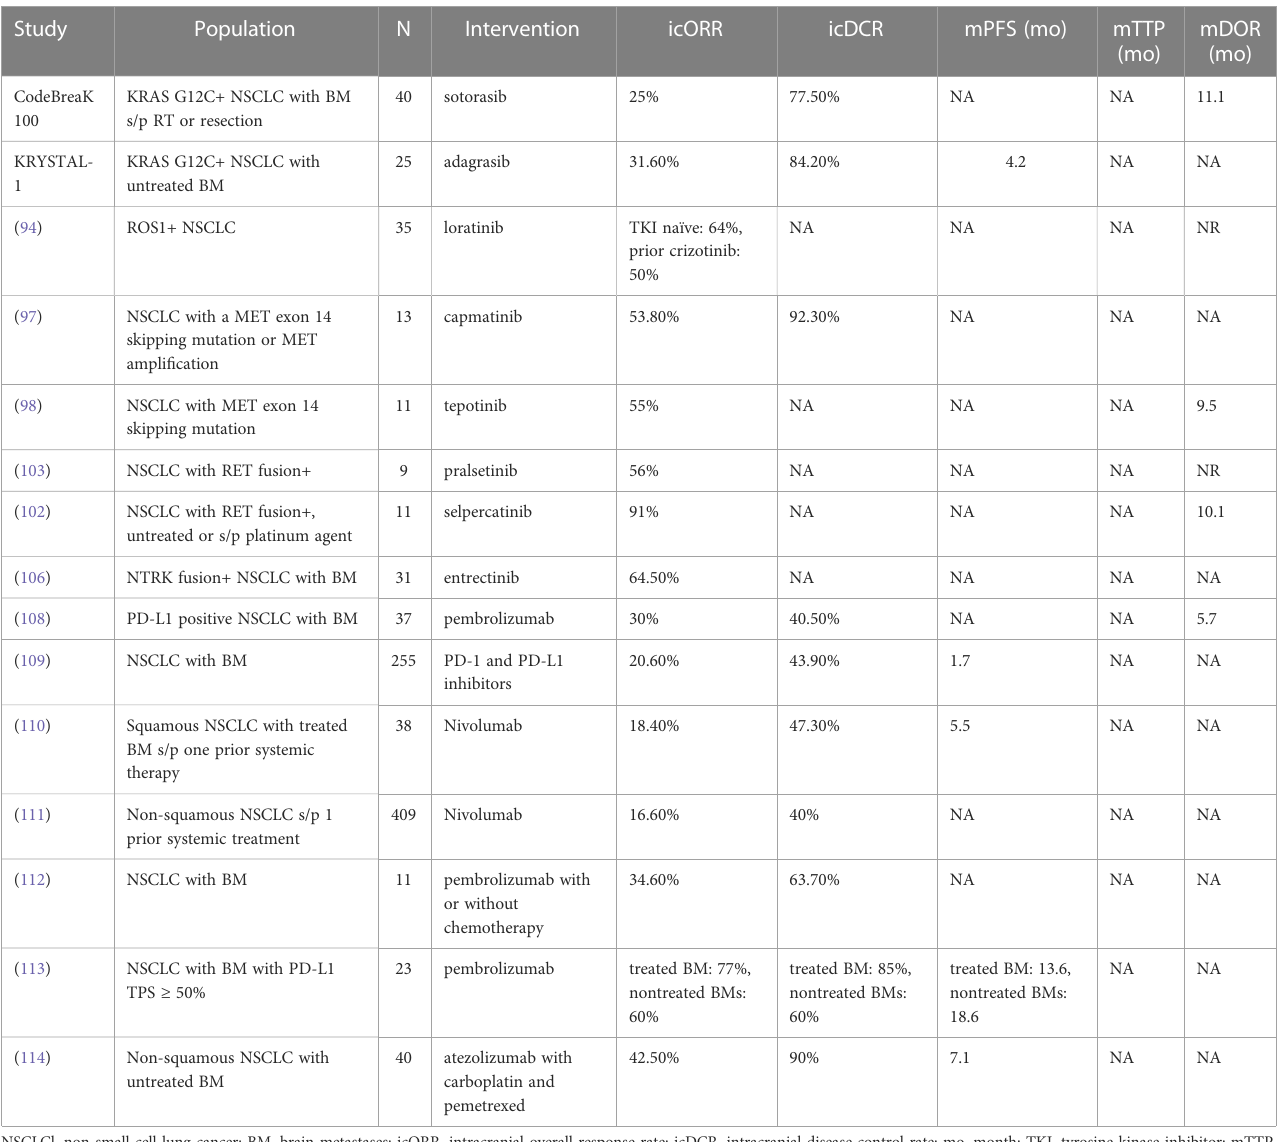
TABLE 3 CNS-related Clinical Outcomes of Other Targeted Therapies and Immunotherapy in NSCLC with Brain Metastases. Study